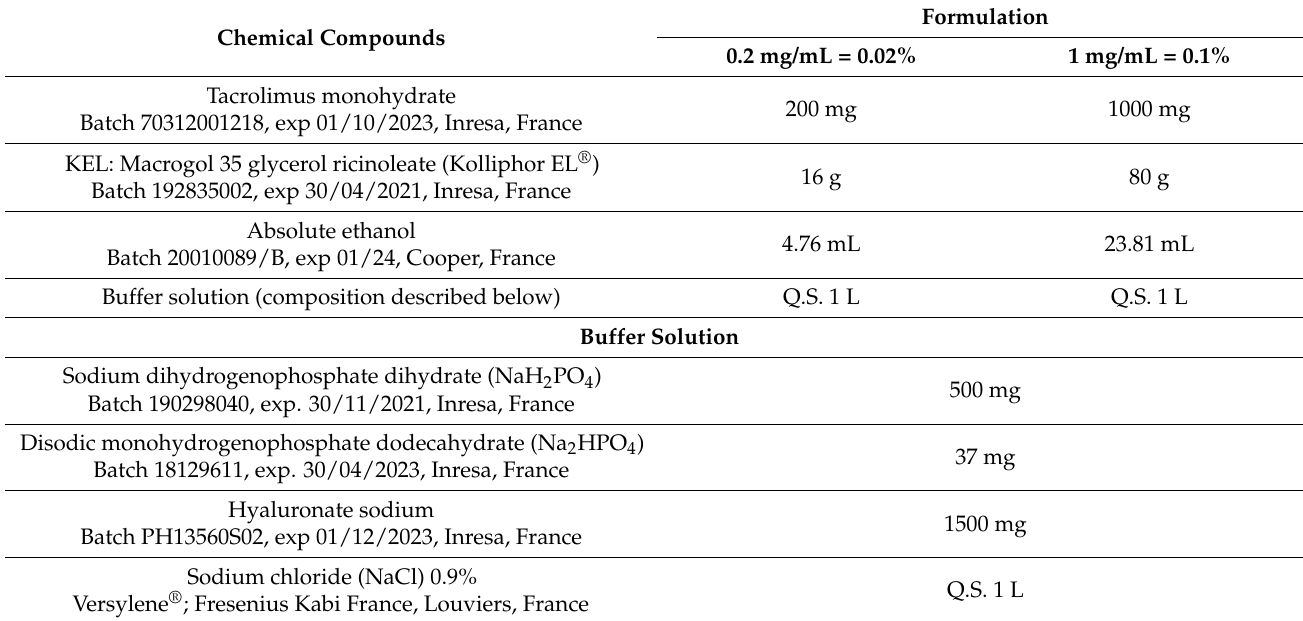
Table 1. Composition of the tacrolimus ophthalmic formulations. Q.S: Quantity